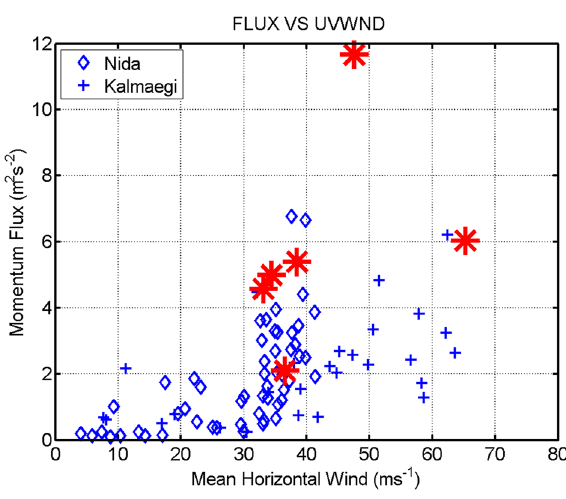
Figure 7. Plot of the momentum fluxes from all legs in Typhoons Nida (diamond) and Kalmaegi (+) as a function of the mean horizontal wind speed of each leg. Red stars represent the roll